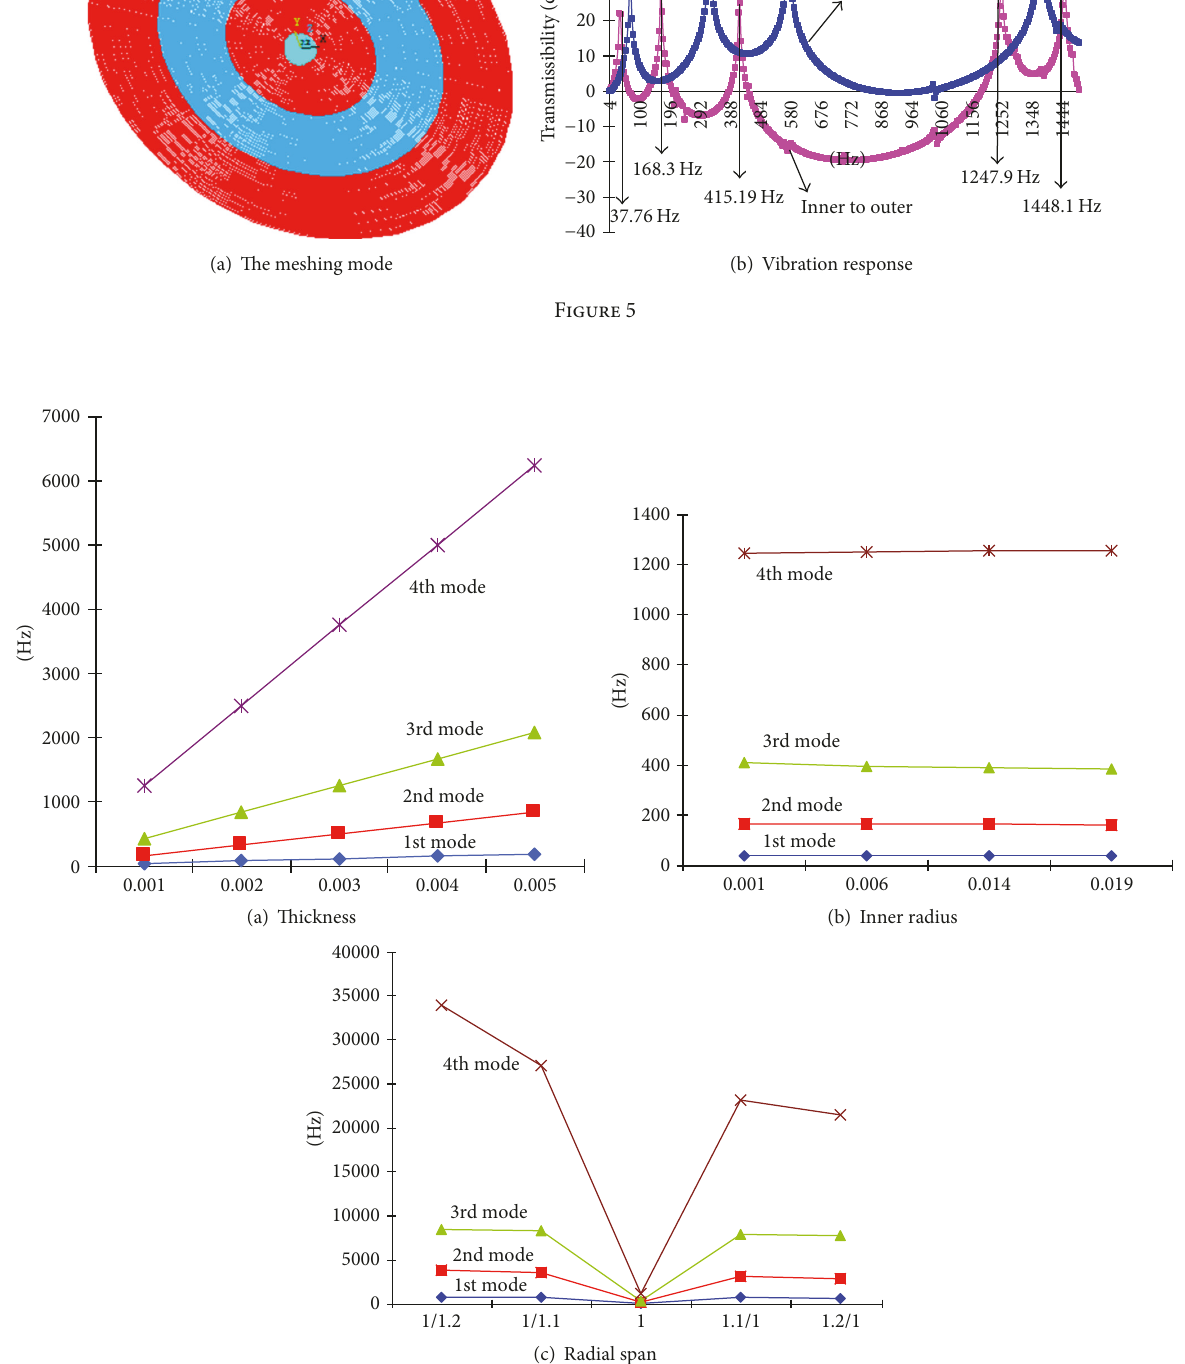
Figure 6: Effect of structural